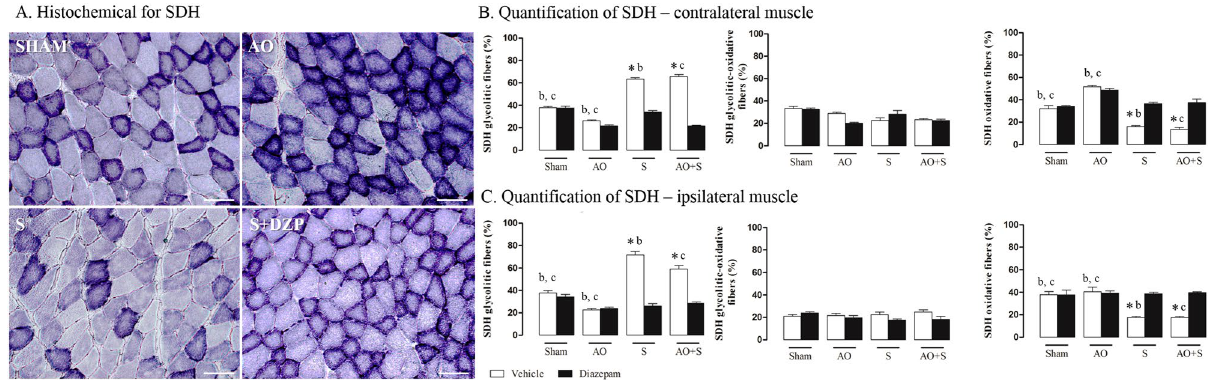
Figure 3. Effects of stress, occlusal instability and diazepam treatment on succinate dehydrogenase enzyme (SDH). ( A ) Panels show representative photomicrographs of SDH staining of the right MPM of control rats (SHAM) and rats submitted to Altered Occlusion (AO), chronic stress (S) or stressed group treated with diazepam (S + DZP), 40 × magnification. ( B ) Demonstration of SDH in different groups of rats. Graph indicates number of glycolytic fibers (light), glycolytic-oxidative fibers (intermediate) and oxidative fibers (dark) in control rats (Sham) and rats submitted to altered occlusion (AO), chronic stress (S) or both (AO + S) (n = 8 per group) in contralateral and ipsilateral muscles. Two-way ANOVA indicated an effect of exodontia and stress, isolated or associated. Data were expressed as mean ± SEM. SEM: standard error means. * P < 0.05 vs diazepam